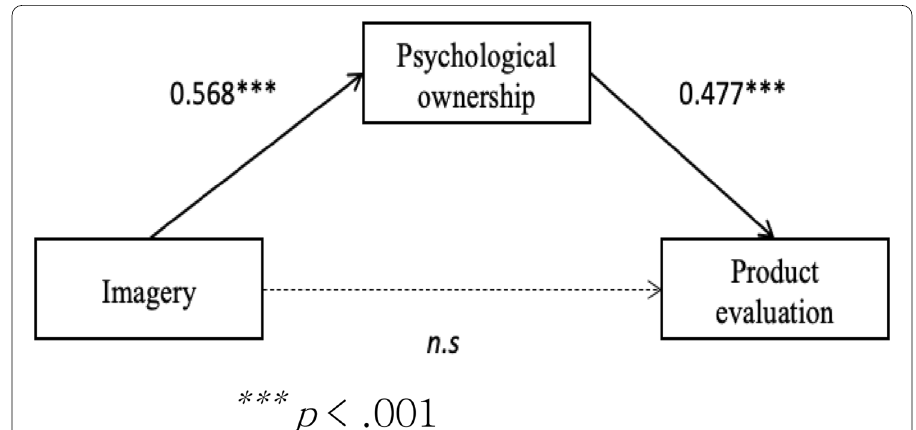
Fig. 4 Mediation of psychological ownership in the effect of imagery on product evaluation